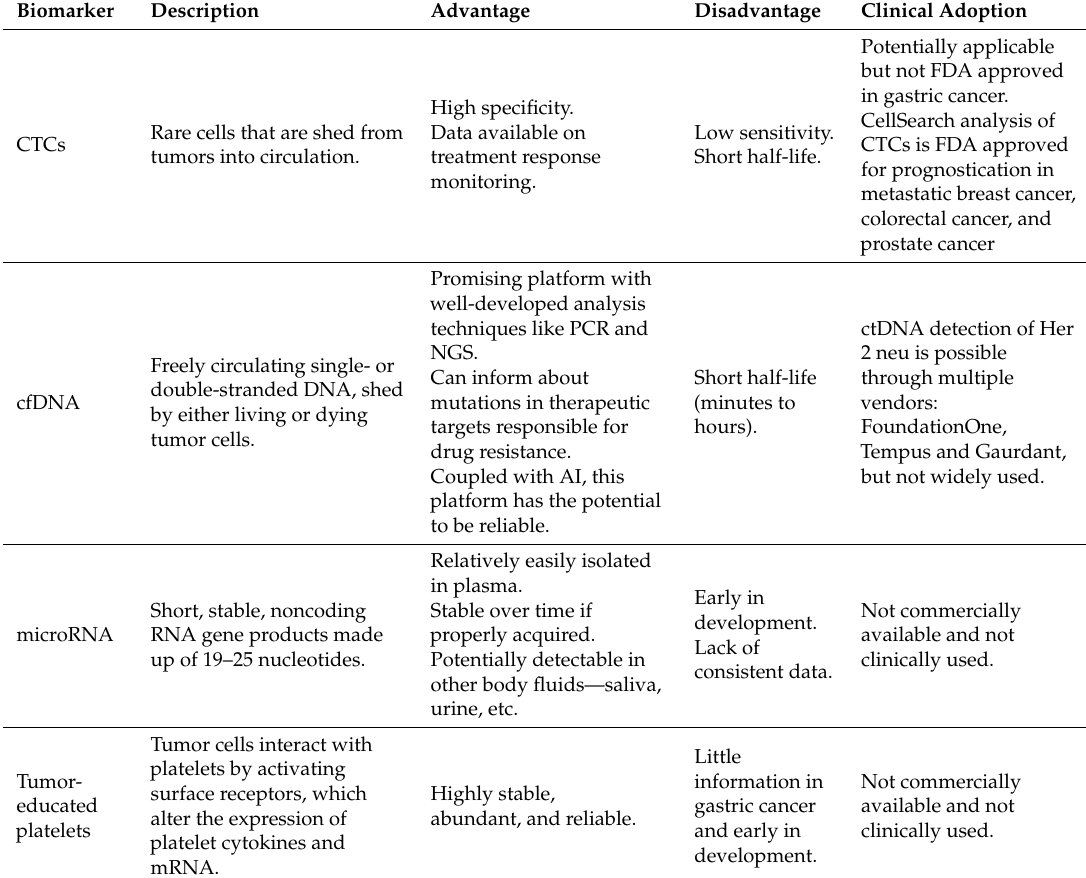
Table 3. Biomarker of liquid biopsies studied in gastric cancers.